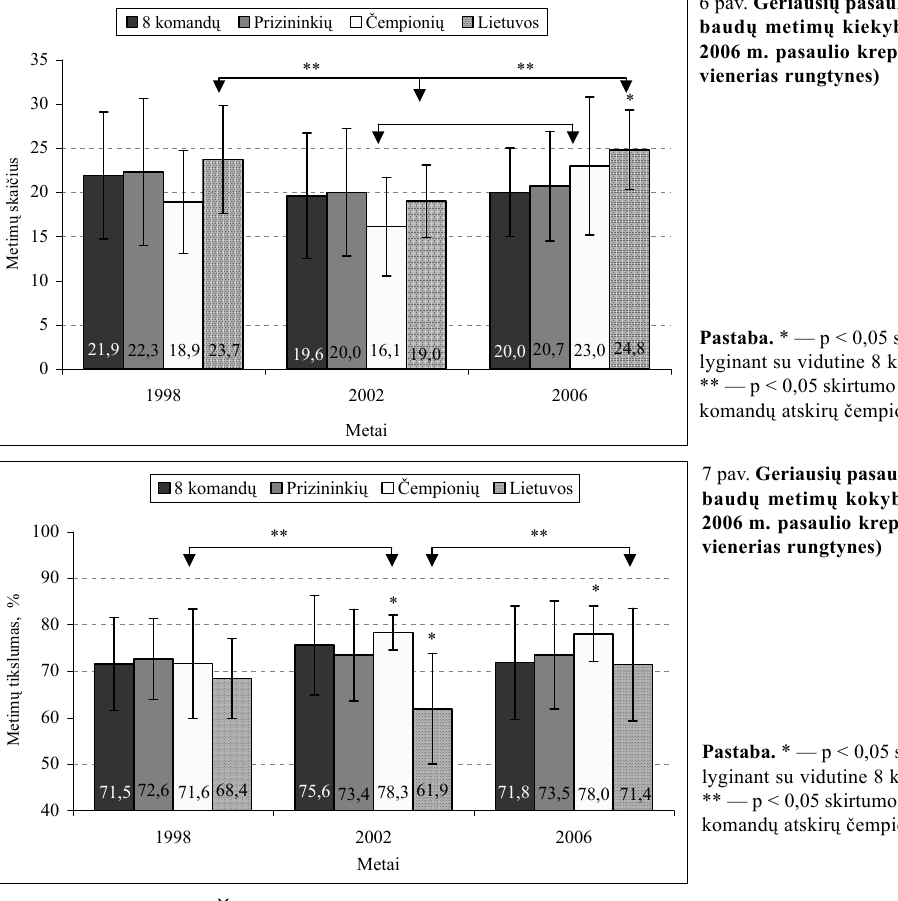
1. Kiekybiniai metim ų į krepš į rodikliai,